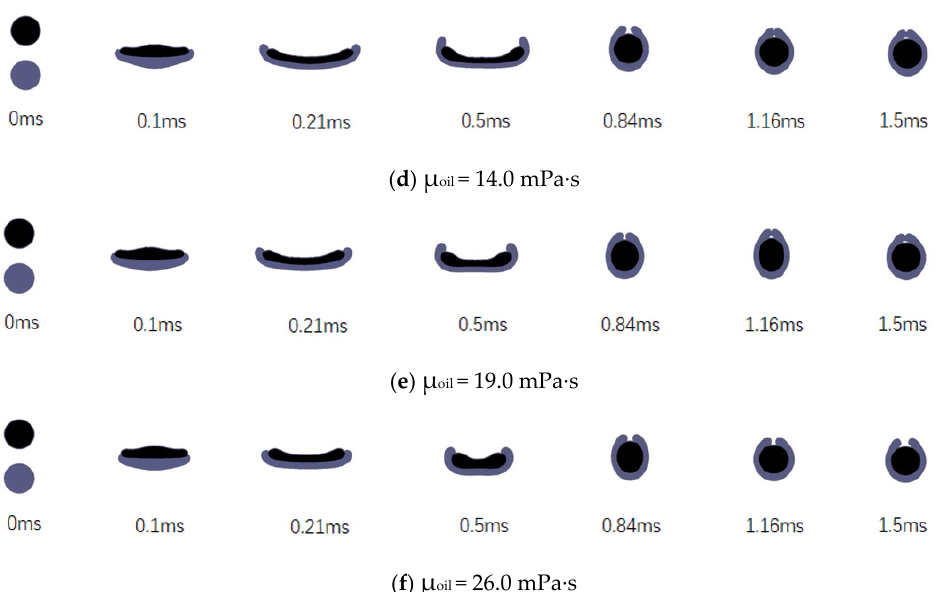
Figure 8. Simulated images of the collision process between a water/glycerol droplet and a silicone oil droplet at different viscosities of the oil phase: ( a ) 2.7 mPa·s; ( b ) 5.5 mPa·s; ( c ) 9.0 mPa·s; ( d ) 14.0 mPa·s; ( e ) 19.0 mPa·s; ( f ) 26.0 mPa·s. Table 4. Droplets’ physical properties and geometric parameters. Droplet 1 Droplet 2 Liquid Water/glycerol mixture Silicone oils